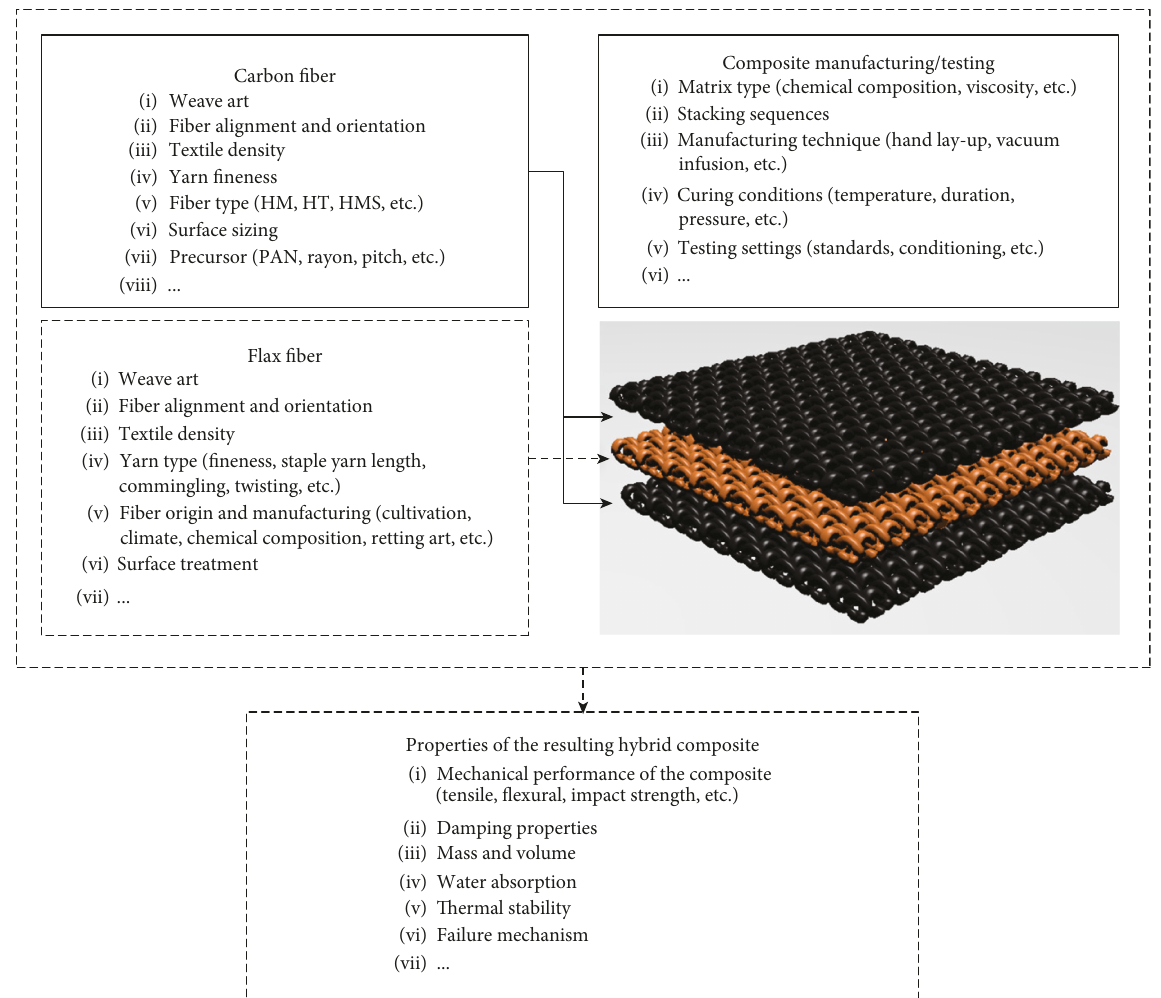
Figure 1: Factors a ff ecting the properties of the resulting hybrid carbon/ fl ax